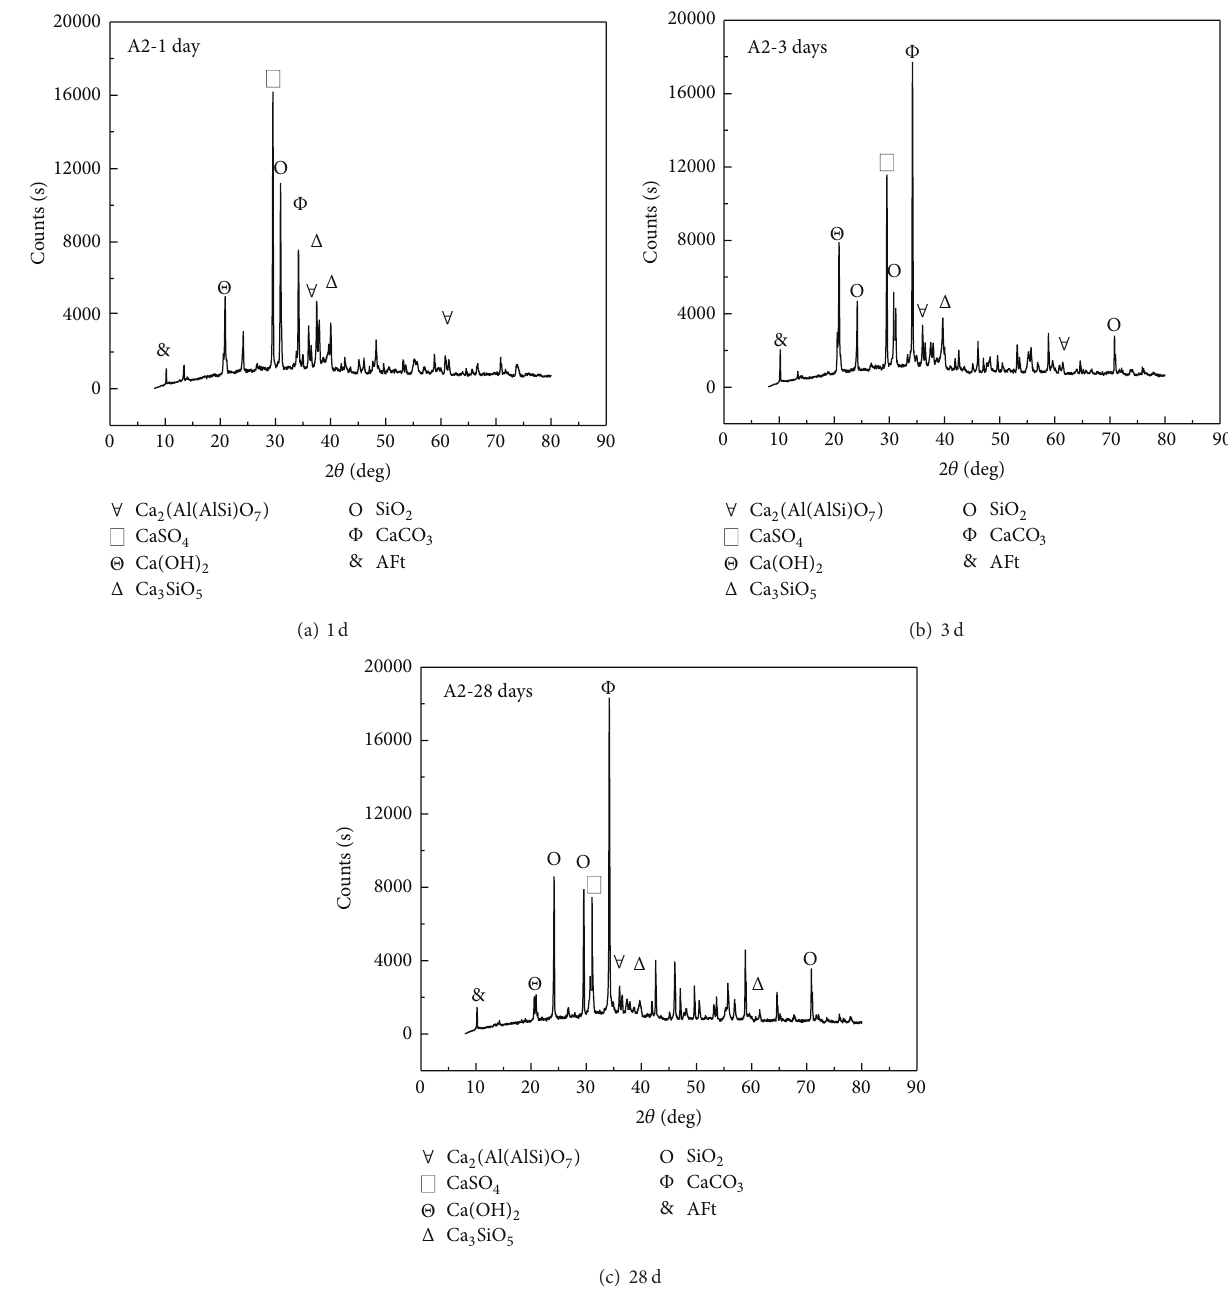
Figure 6: XRD patterns of gypsum-bauxite grouting